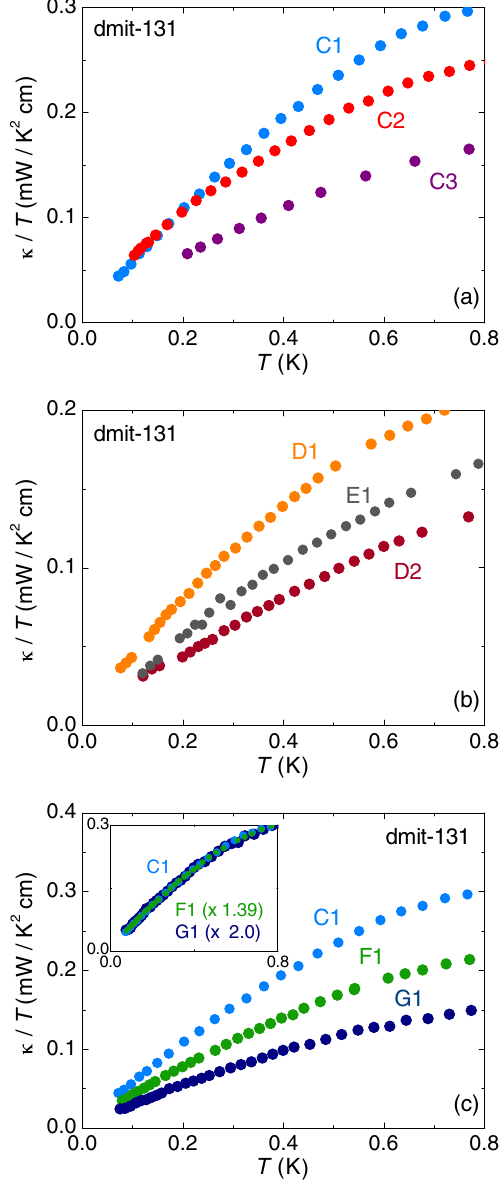
FIG. 1. Thermal conductivity κ ð T Þ of dmit-131, expressed as κ =T vs T , for samples C1, C2, C3 (a), samples D1, D2, E1 (b), and samples C1, F1, G1 (c). All data are in zero magnetic field. In panel (c), the inset compares data for C1 with the data for F1 and G1 multiplied by 1.39 and 2.0,